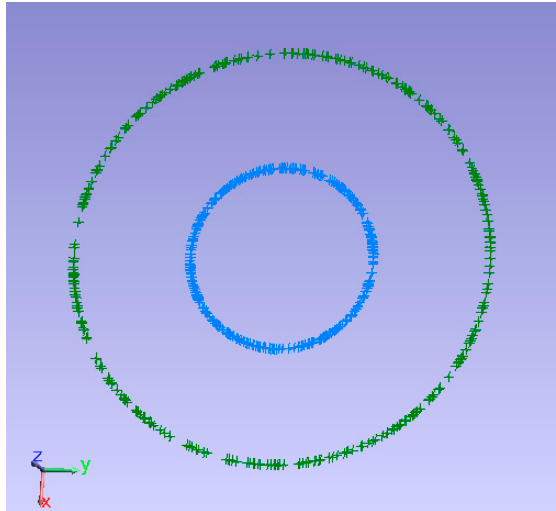
Figure 10. Circumferential dynamic test’s target point trajectory.